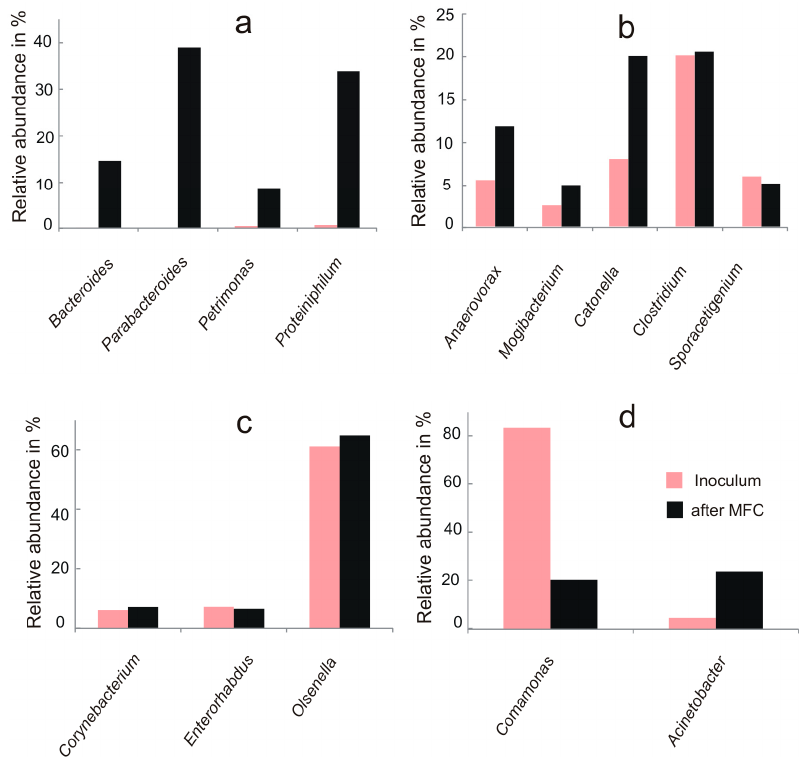
Figure 4. The relative abundance of bacteria genera in different phyla: ( a )— Bacteroidetes ; ( b )— Firmicutes ; ( c )— Actinobacteria ; ( d )— Proteobacteria .